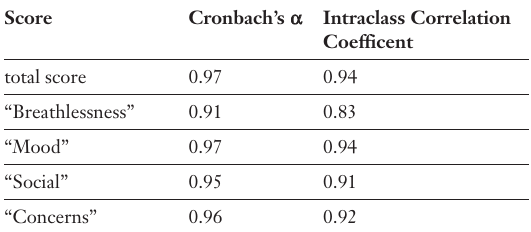
Figure 2 Change in individu- als’ total scores when questionnaire is given to the pa- tients one week later without modification of treatment indicat- ing a good test- retest-reliability (n = 12). The second lowest line (starting with a total score of 1) rep- resents the observa- tions of two different patients.